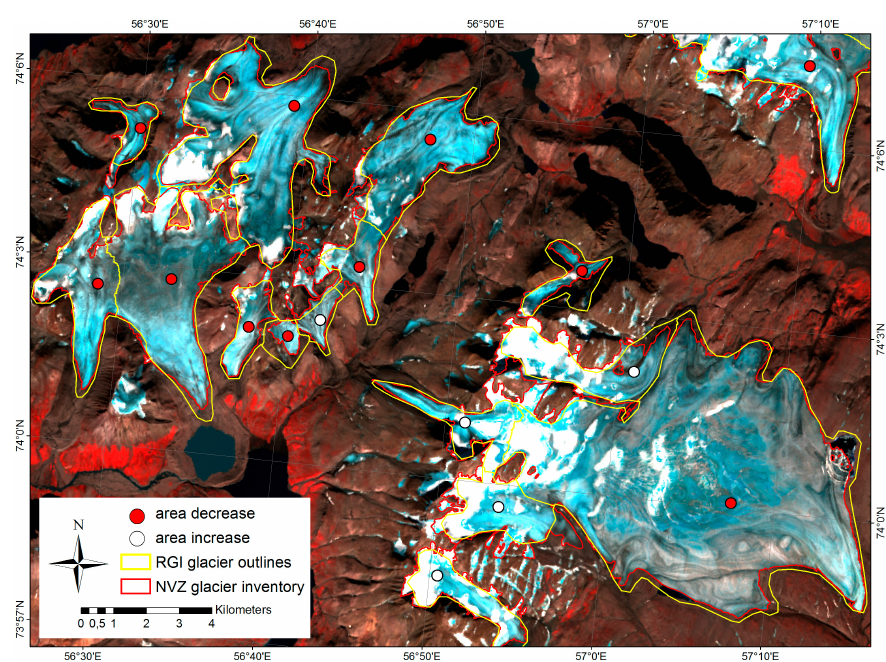
Figure 10. The problem of area increase and decrease exemplified for a small region in the southern part of Novaya Zemlya. Positive area changes are due to mostly the semi-automatic mapping method used in this study. Negative area changes are due to glacier shrinkage through time.